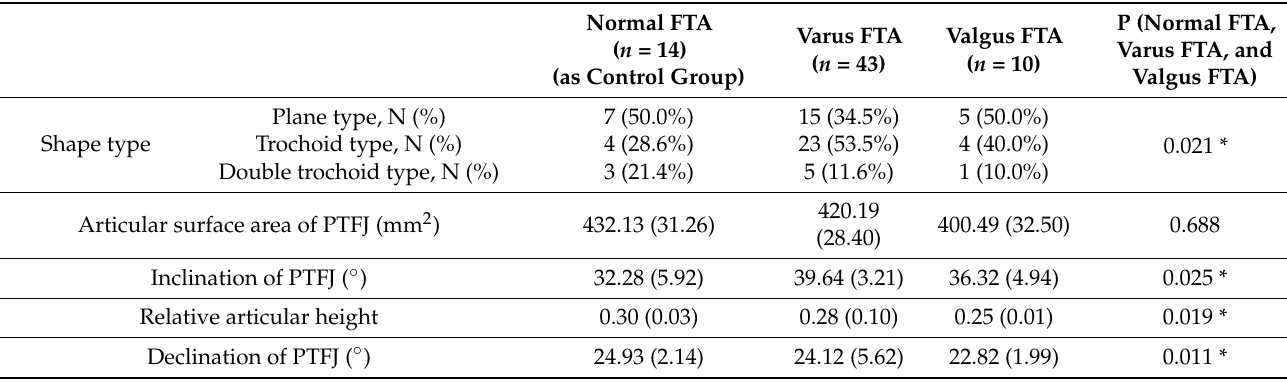
Table 2. Characteristics of the proximal tibiofibular joint (PTFJ) in the three groups (normal femorotibial angle (FTA), varus FTA, and valgus